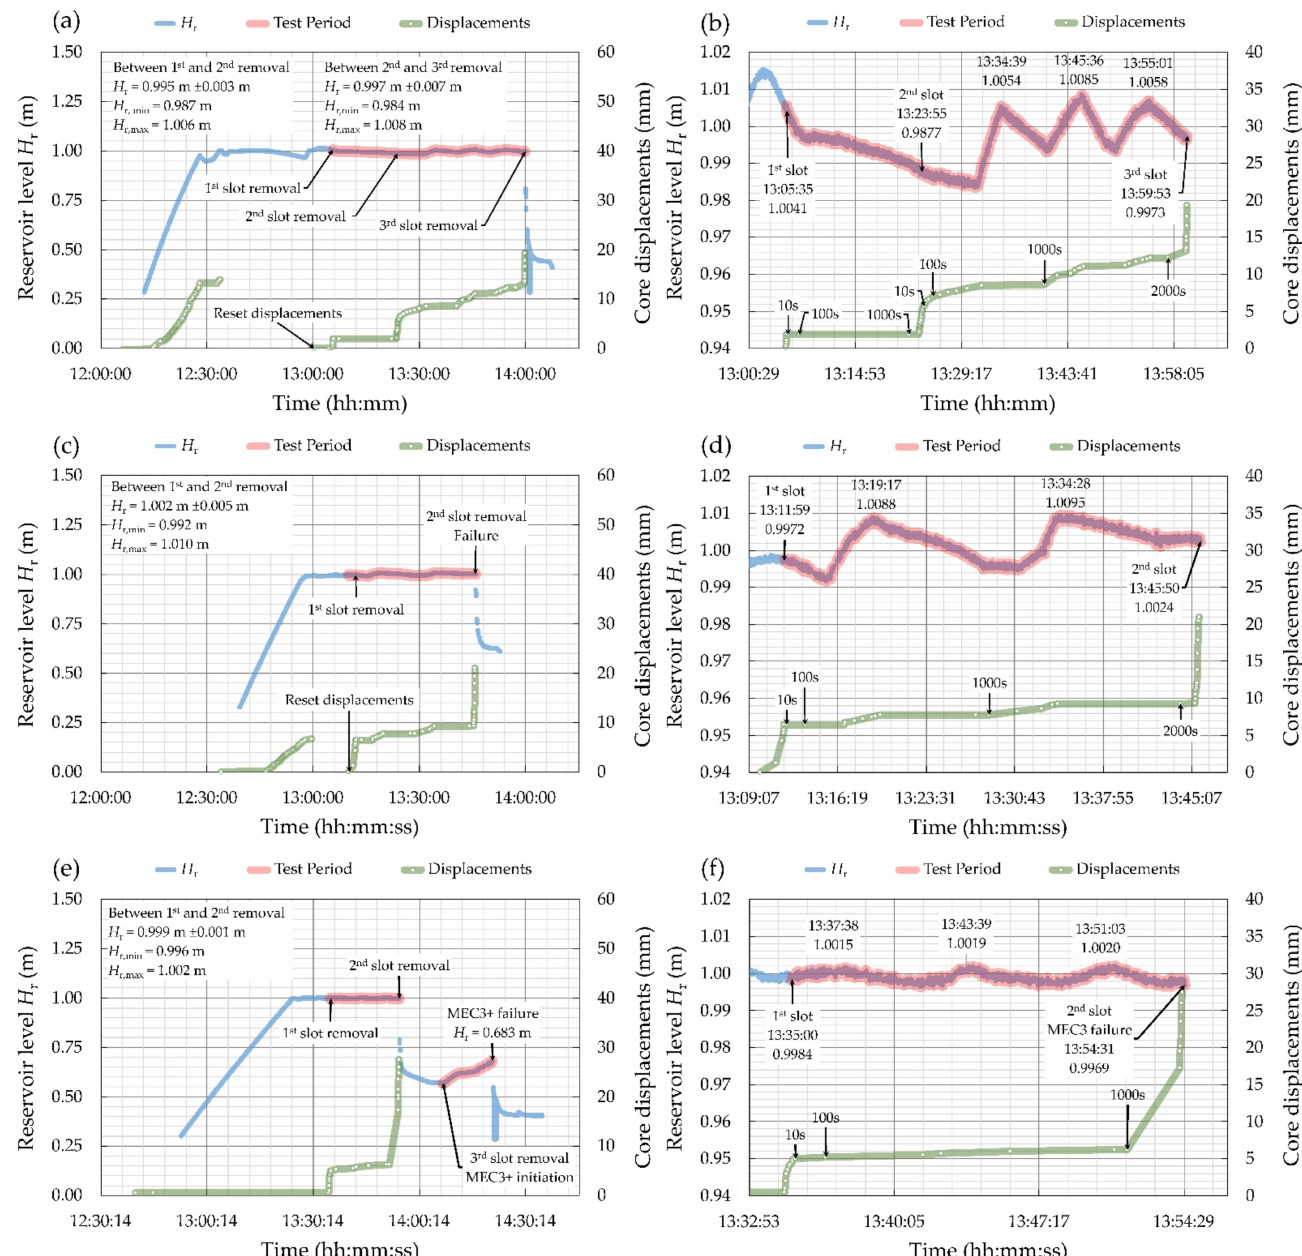
Figure 10. Reservoir level elevation and the cohesive core displacements. ( a ) Test MAIN1 including the reservoir filling period; ( b ) Detail of the test MAIN1; ( c ) Test MAIN2 including the reservoir filling period; ( d ) Detail of the test MAIN2; ( e ) Tests MAIN3 and MAIN3+ including the reservoir filling period; ( f ) Detail of the test MAIN3. The times 10 s, 100 s, 1000 s, and 2000 represent the time in seconds elapsed from the moment a given protection slot was